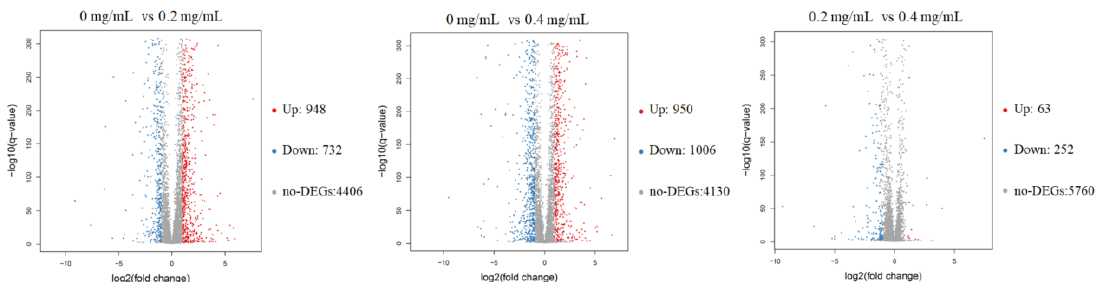
Figure 4. The volcano plots of the differentially expressed genes of C. albicans treated with SSE at the concentrations of 0, 0.2, and 0.4 mg/mL for RNA-seq analysis. The red and blue dots indicated the significantly differentially expressed genes with up-regulation and down-regulation, respectively. The red dot indicates up-regulation (Up); the blue dot indicates down-regulation (Down); the grey dot indicates no differentially expressed genes (no-DEGs).